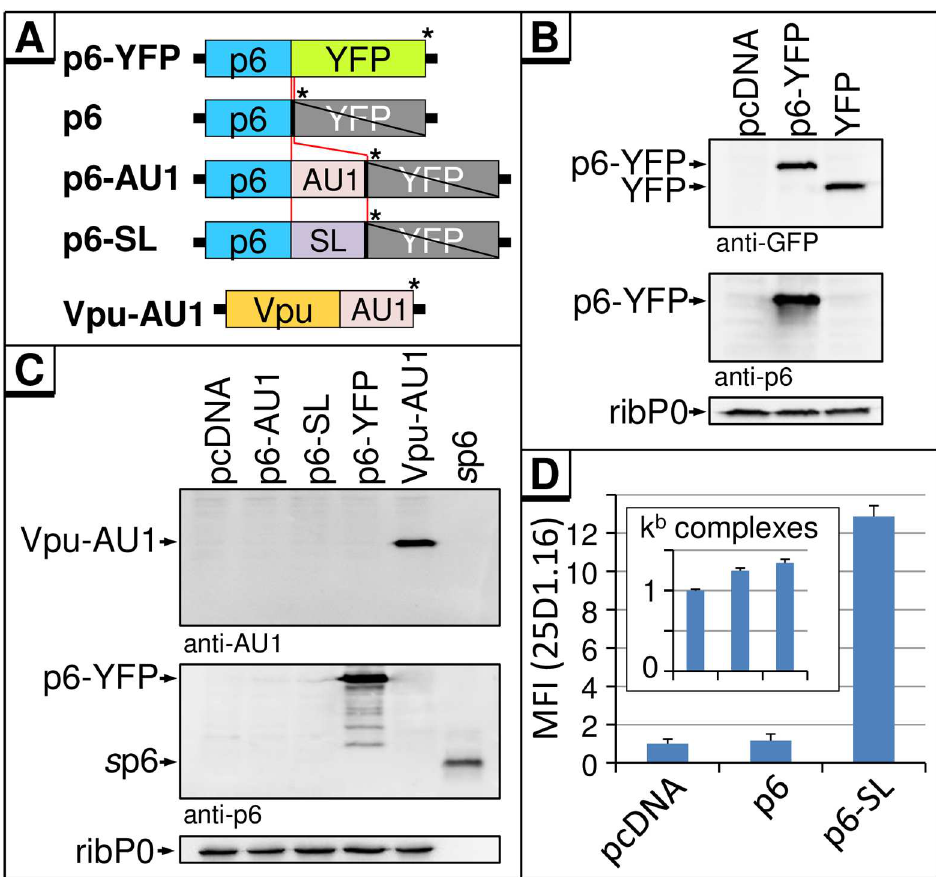
Fig 2. p6is expressed asa YFP-fusion, but is highly turnedoverwhen expressedasan autonomous protein. (A) Schematic depictionof the CMV-drivenexpressionplasmids.For ectopicexpressionof p6,a codon- optimized p6 genewasfusedtoYFP andclonedintothe vectorpcDNA(p6-YFP).By insertionofa stopcodon( * ) afterthe p6 ORF, translationofYFP-fusionpartwasabrogated.Additionalvectorswereestablished withanAU1 tagora SIINFEKL(SL)-epitopeatthe C-terminusof the p6 ORF. For control,the Vpu-AU1constructencodesa Vpuproteinharboring anAU1tag. (B) HeLacellsweretransfectedwithplasmidsindicatedandexpressionof p6-YFPfusionwasdetectedwithantibodiesspecificfor GFP orp6.Stainingforthe ribosomalP-antigen(ribP0) servedasloadingcontrol. (C) CytosolicextractsfromHeLacellstransfectedwithindicatedconstructswere analyzedby Western blottingusingantibodiesspecificfor AU1orp6. 20ngof s p6servedascontrolfor the anti-p6 staining. (D) HeLa-K b cellsweretransfectedwithp6-expressionconstructs, codingforp6orp6-SLandas an emptyvectorcontrolpcDNA.H2-K b -SLcomplexespresented onthe cellsurfacewerequantifiedby flowcytometry usingthemAb 25D1.16-APC.Inset: thetotalamountof H2-K b complexeswasdeterminedbythe mAbB8-24-3. Quantificationoffive independent experiments; Barsrepresentmeanvalues ±